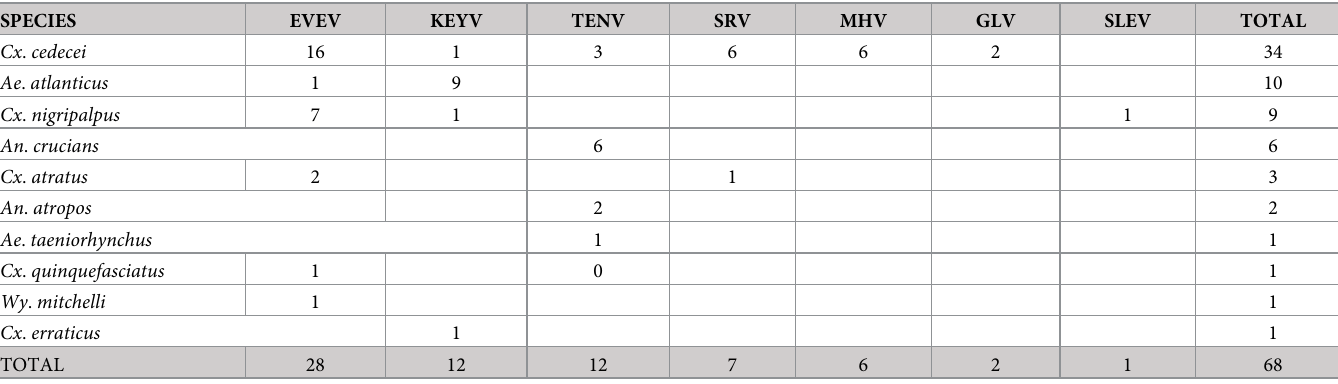
Table 1. Arboviruses isolated from all mosquito species, 2013–2014.